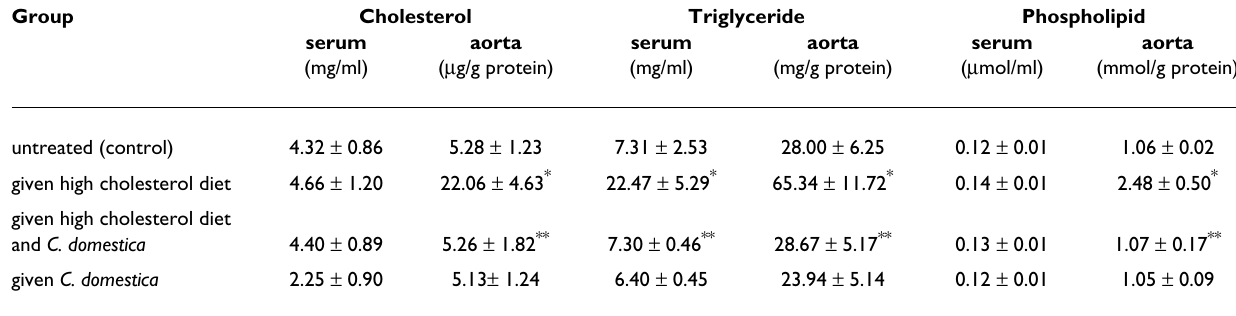
Table 1: Effect of C. domestica on cholesterol, triglyceride and phospholipid levels in the serum and aorta. Group